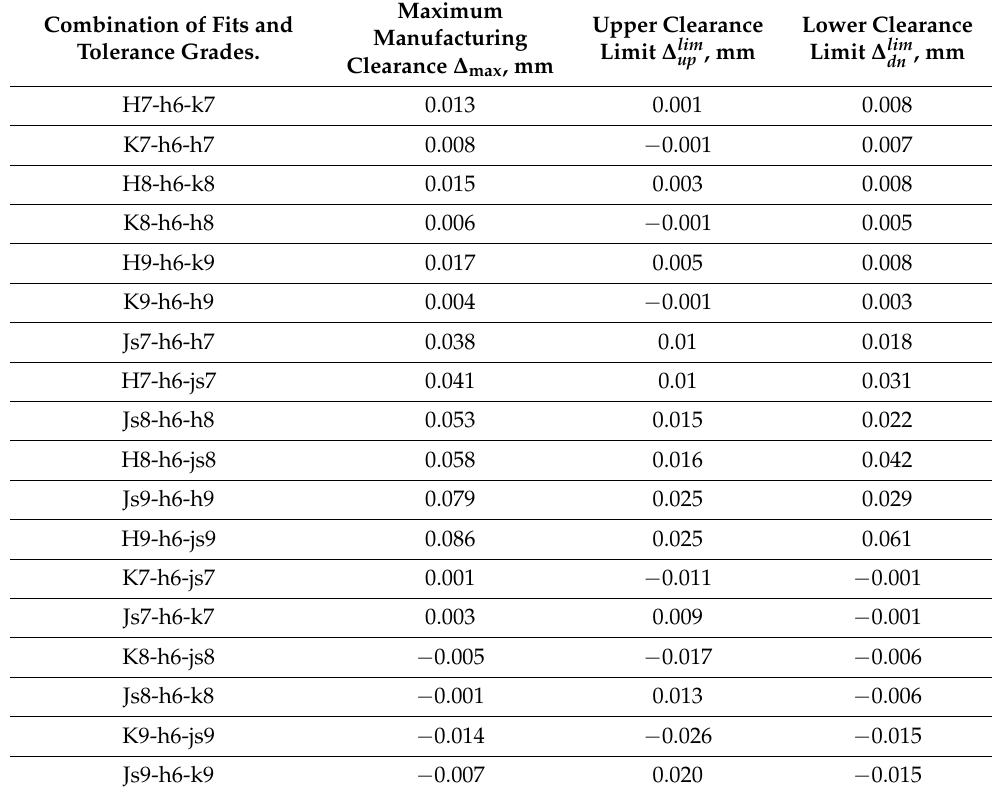
Table 1. Values of manufacturing clearances when changing the tolerance grade and combination of fits.